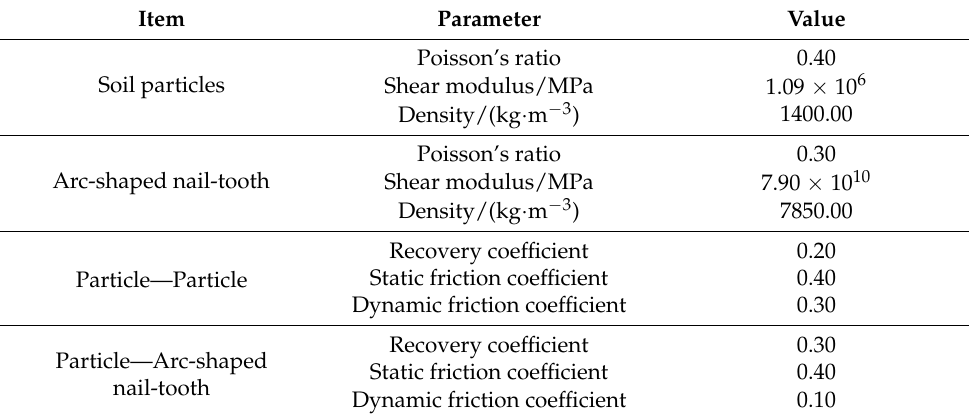
Table 1. Simulation parameter settings of soil particles and geometry.